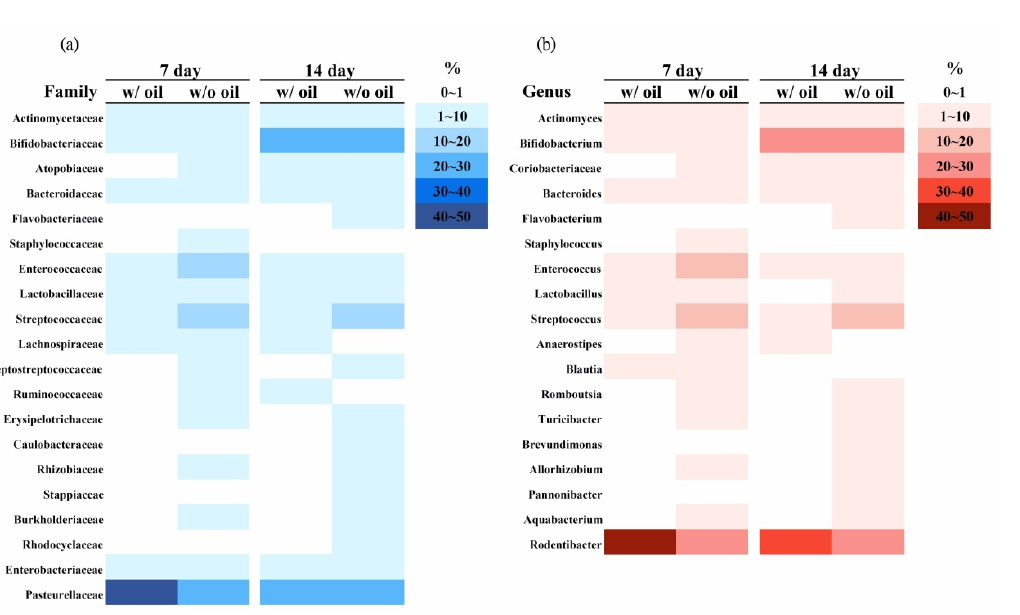
Figure 6. Tested teeth were subjected to ligature-induced periodontitis. Data from samples treated with and without SM oil were compared. Sub-figures show box plot analysis in the phylum of ( a ) Firmicutes , ( b ) Bacteroidetes , ( c ) Proteobacteria and ( d ) Actinobacteria .